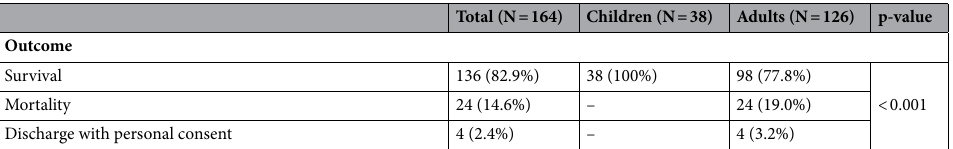
Table 1. Demographic and clinical characteristics of adultand children patients with confirmed mucormycosis (n = 164). † Rare forms include iatrogenic mucormycosis, abscess formation in the neck and pterygoid muscle. ‡ Other Predisposing factors include chronic kidney disease, thalassemia major and long-term use of Deferoxamine. § LAMB Liposomal amphotericin B.